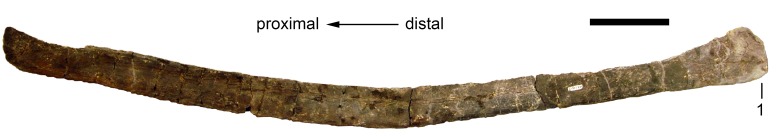
Right dorsal rib ?3 of Galeamopus pabsti SMA 0011 in lateral view.The rib head is not preserved. Note the distal expansion for the attachment of sternal cartilages (1). Scale bar = 10 cm.